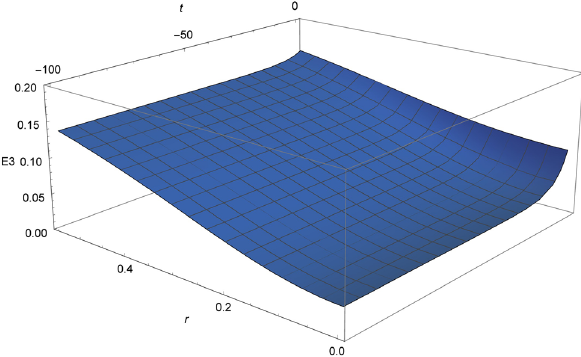
Fig. 9 Energycondition3, c 1 = 0 . 81, c 2 = 0 . 5, c 3 = − 10, c 4 = − 10, ζ = − 0 . 2, R = 6 . 62, r = 0 . 55 and (cid:7) = 0 . 0